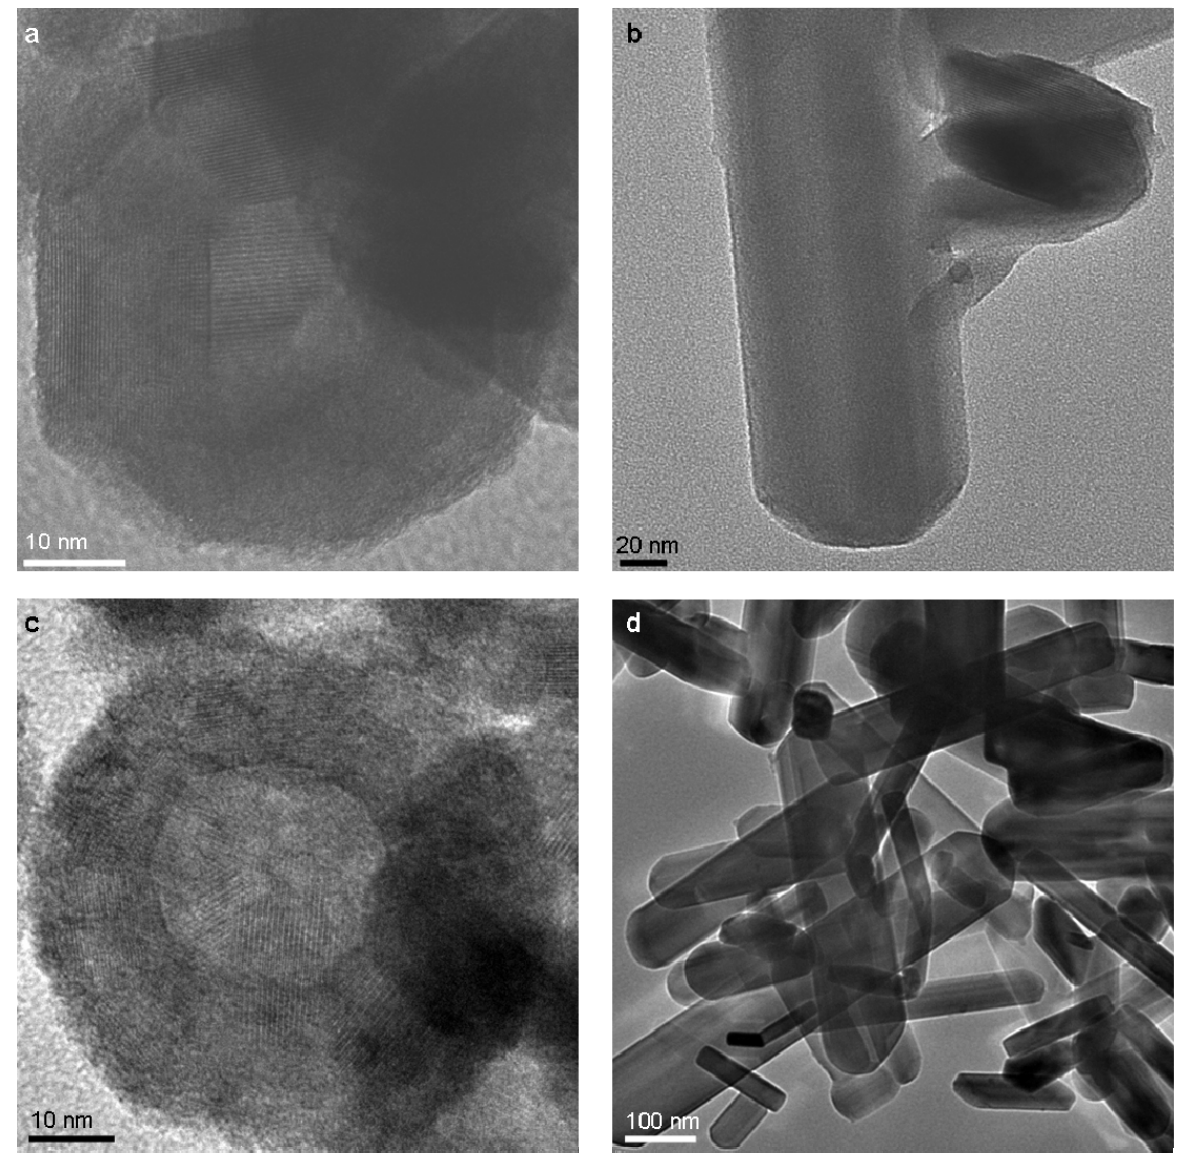
Figure 7. TEM images of PLA products after a PRT of three hours (a) T = 300 ° C, O flow rate-40 mL/min—a collapsed NIF-V V O platelet ( c) T = 300 °C, O 2 5